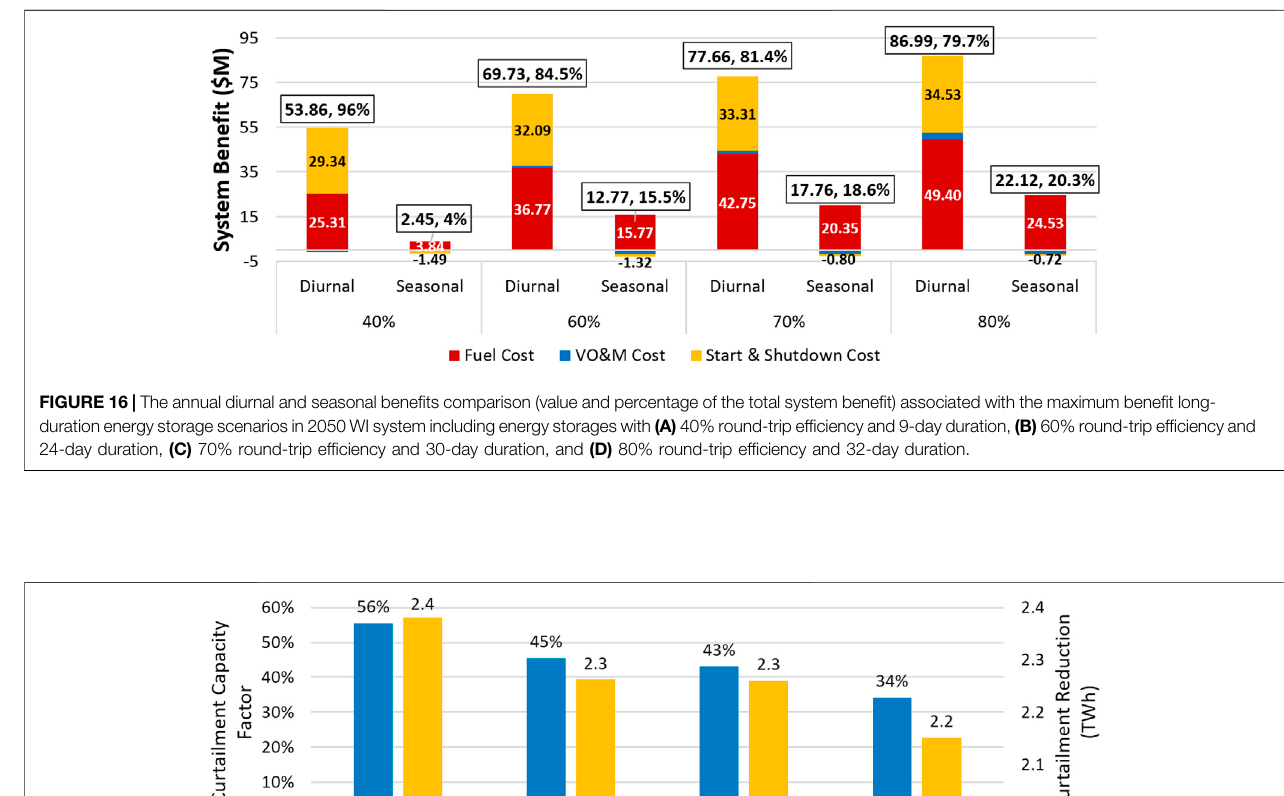
FIGURE 15 | The annual bene fi ts from providing ancillary services including fl exibility, regulation, and spinning reserves associated with the maximum bene fi t long-duration energy storage with 40, 60, 70, and 80% round-trip ef fi ciencies.